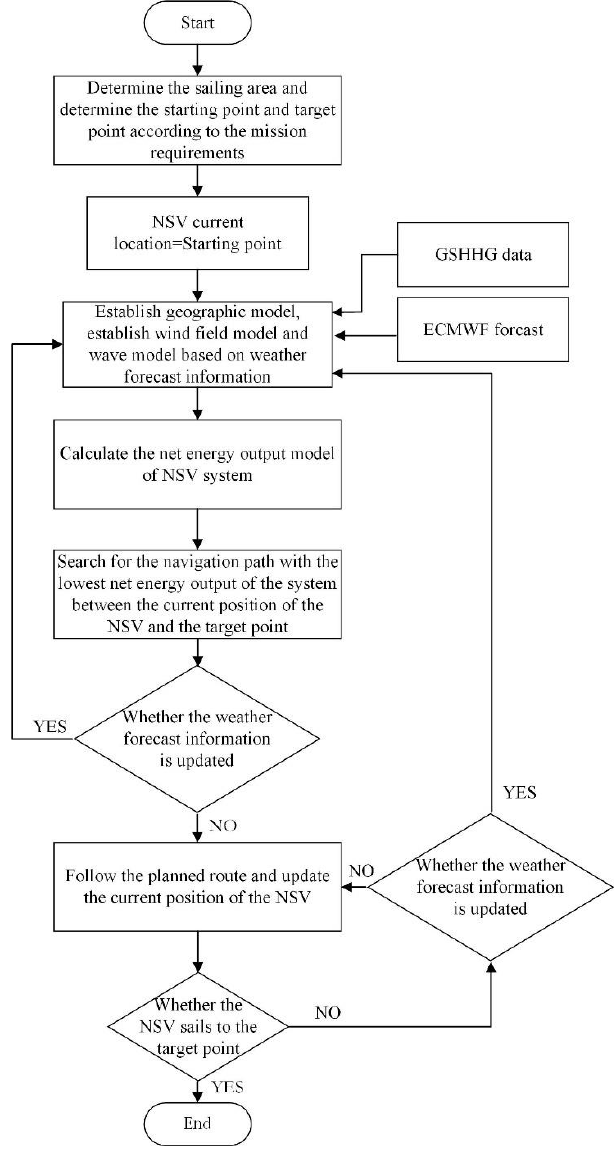
Figure 7. DW – Dijkstra algorithm flow chart. Figure 7. DW–Dijkstra algorithm flow chart.